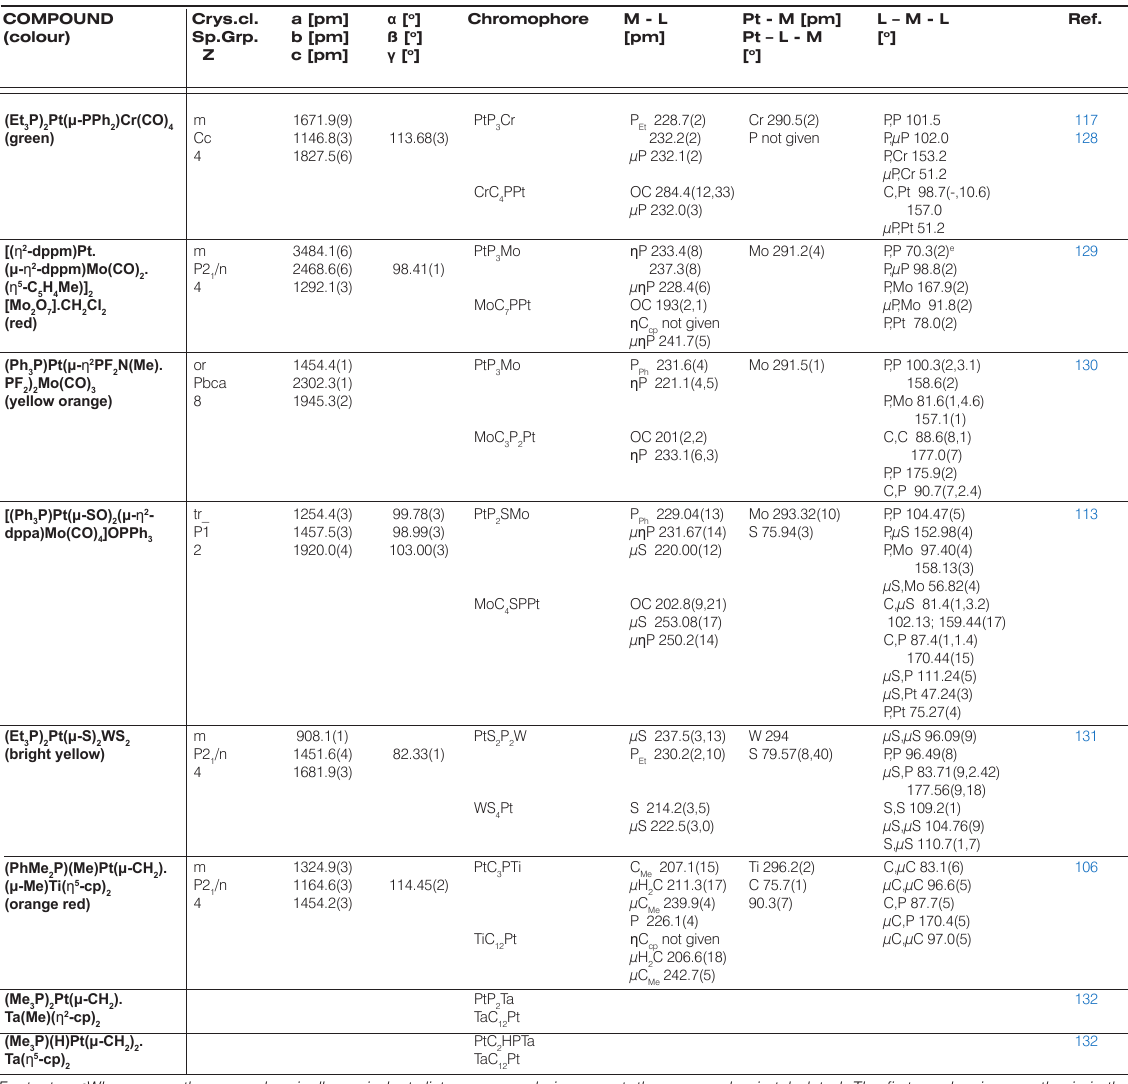
The data for red, orange and yellow derivatives with Mn or Re are gathered in Table 4. Fifteen are Pt/Re